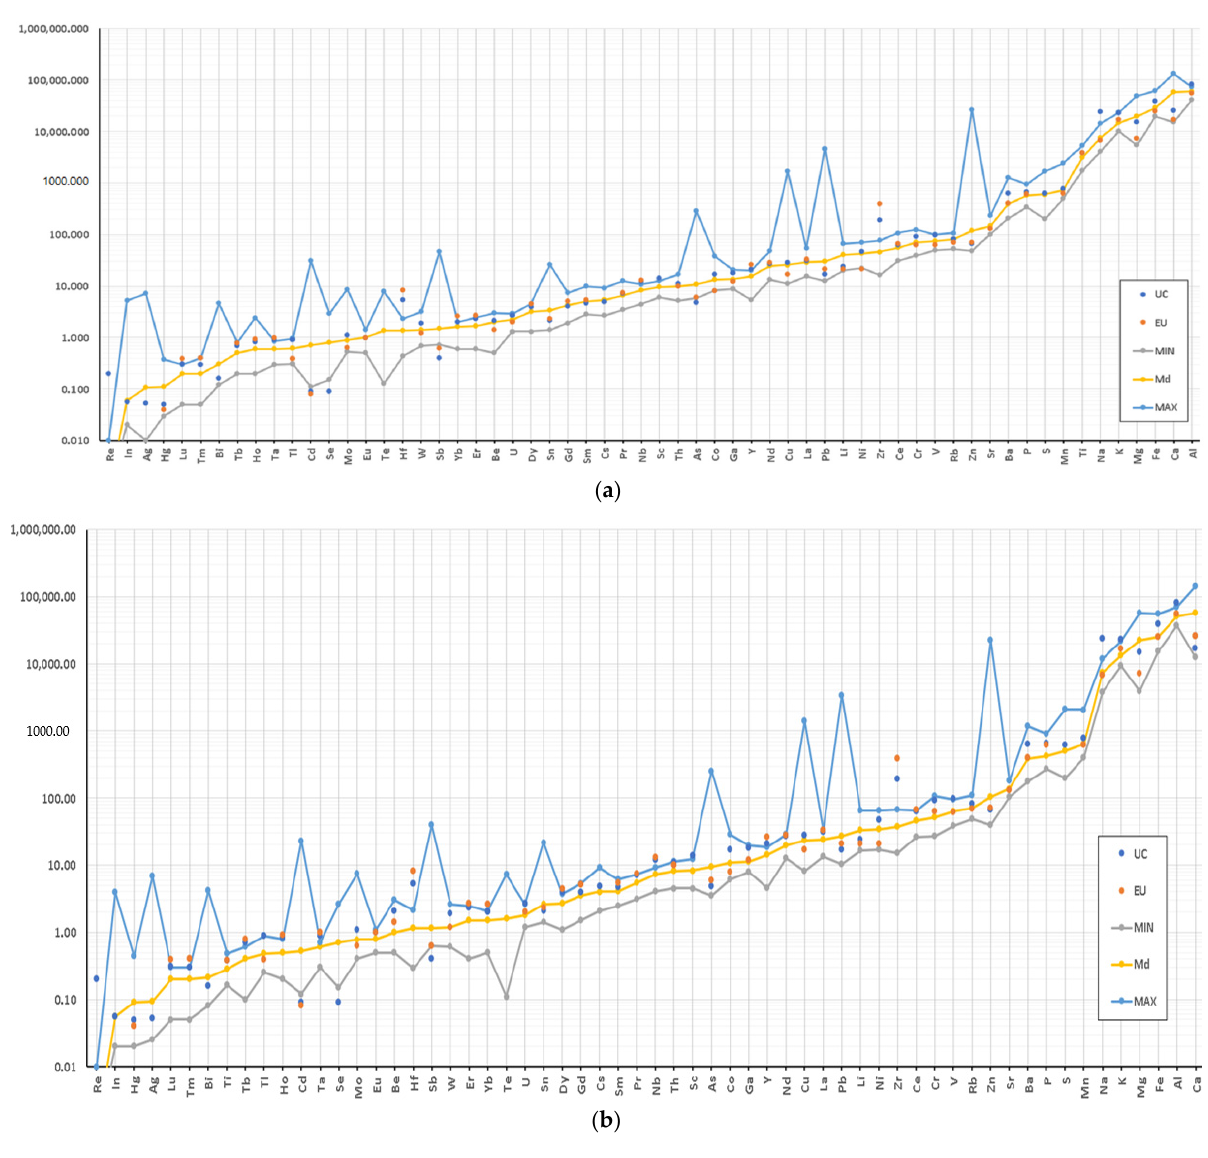
Figure 2. Minimum (MIN), median (Md) and maximum (MAX) levels of elements in the fractions <0.063 mm ( a ) and 0.063–0.125 mm ( b ), and comparison with the corresponding average values for European alluvial sediments (EU) [31] and the upper crust (UC) [32].